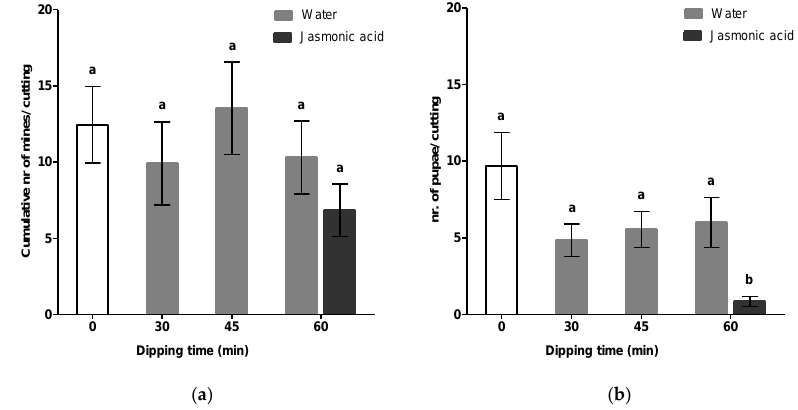
Figure 3. Effect of water dipping and jasmonic acid on leaf miner resistance ( Liriomyza trifolii ). Unrooted cuttings, precoated with indole-3-butyric acid (IBA), were dipped in water for various durations and in a solution of 5 mM jasmonic acid for 60 min. Two weeks post treatment, cuttings were individually caged and infested with four flies for 24 h. ( a ) Total number of mines were scored after 3 days, whereas the number of pupae were counted after one week ( b ). Data are represented as mean ± SEM, n = 13. Different letters indicate significant differences among treatments as determined by a ( a ) Fisher’s least significant di ff erence (LSD) test or ( b ) Games–Howell at p < 0.05. Insects 2020 , 11 , x